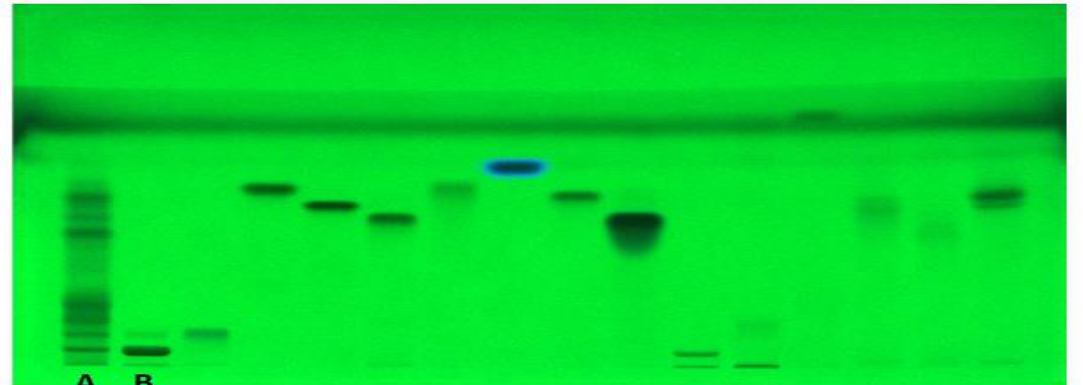
Figure 7. HPTLC for ethyl acetate fraction under UV 254 nm Mobile phase: Ethyl acetate: formic acid: acetic acid: water (84:4:4:10) Isolation of phytochemicals by Preparative Thin Layer Chromotography A-preparative TLC test was performed on hexane fraction to isolate the steroid for further analysis